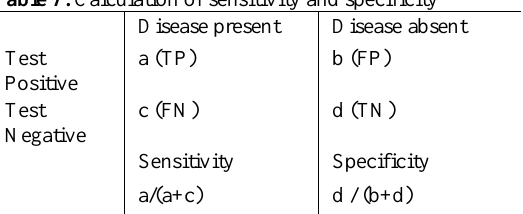
Table 7. Calculation of sensitivity and specificity Disease present Disease absent